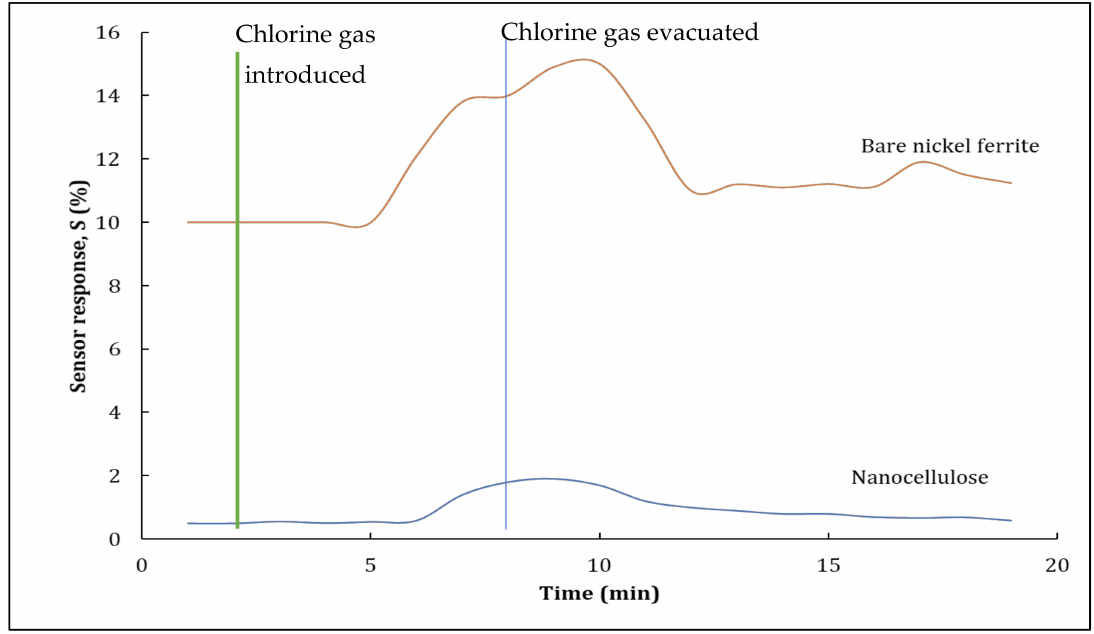
Figure 7. Sensor response of pristine nanocellulose and bare nickel